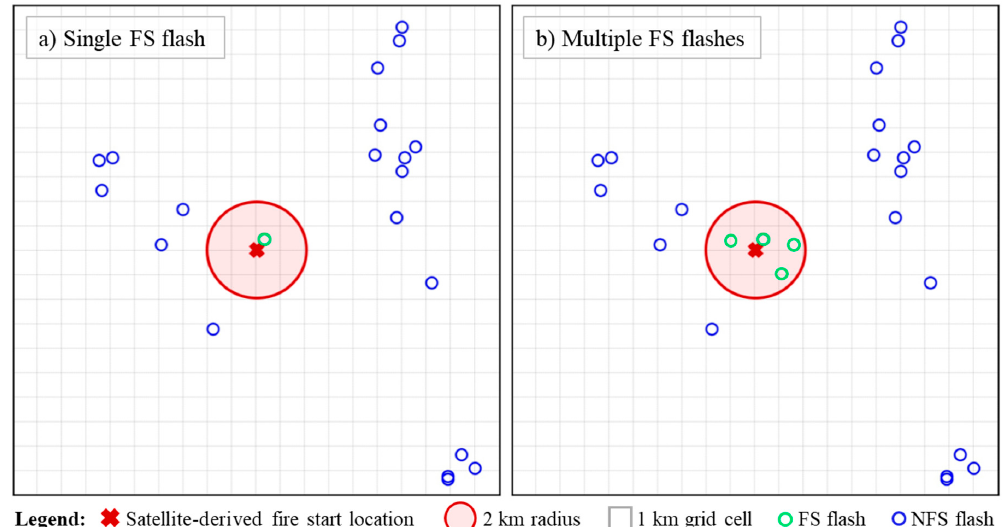
Figure 1. ( a–b ) Locations of cloud-to-ground lightning strokes within a 400 km 2 domain during a 2-h